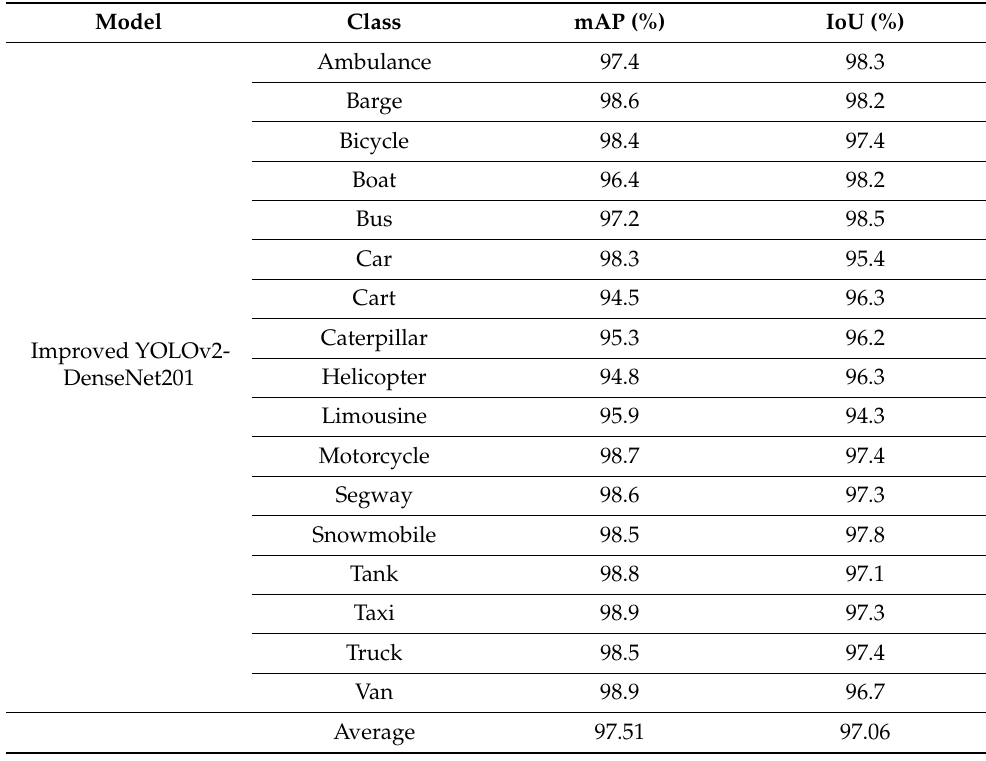
Table 4. Class-wise performance over Kaggle and KITTI